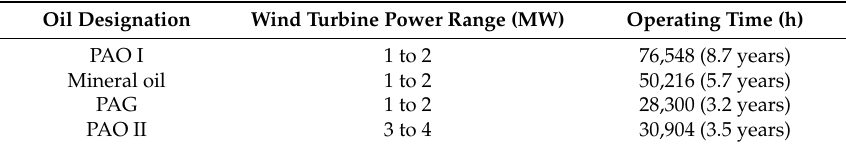
Table 3. Operating years of the oil samples extracted from the